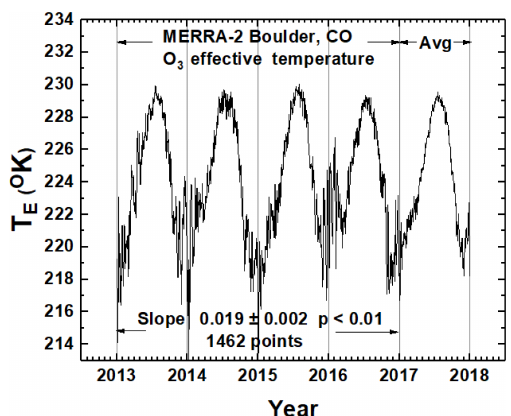
Figure 1. Calculated T E using model estimates of O 3 and tempera- ture profiles. The trend is calculated from the difference of T E from its 4-year daily mean, which is also used for year 2017, labelled Avg.